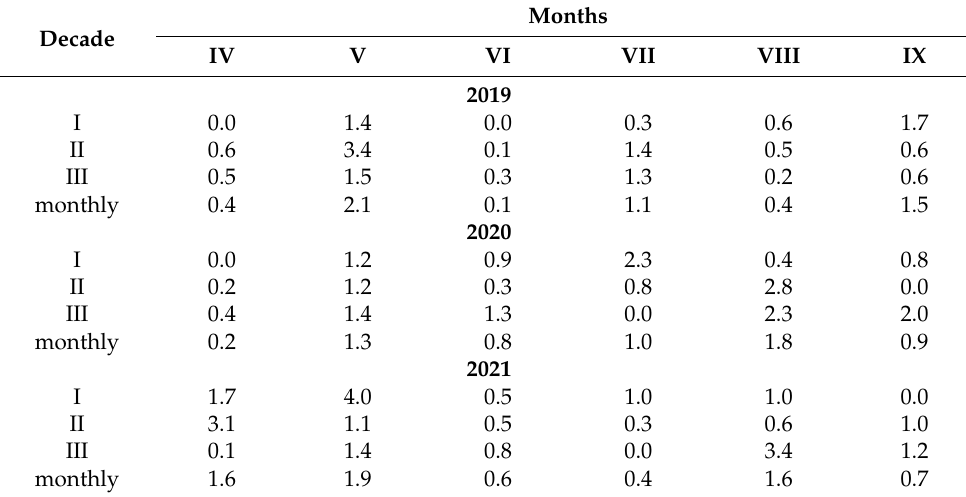
Table 3. Results of the Sielianinov index for individual